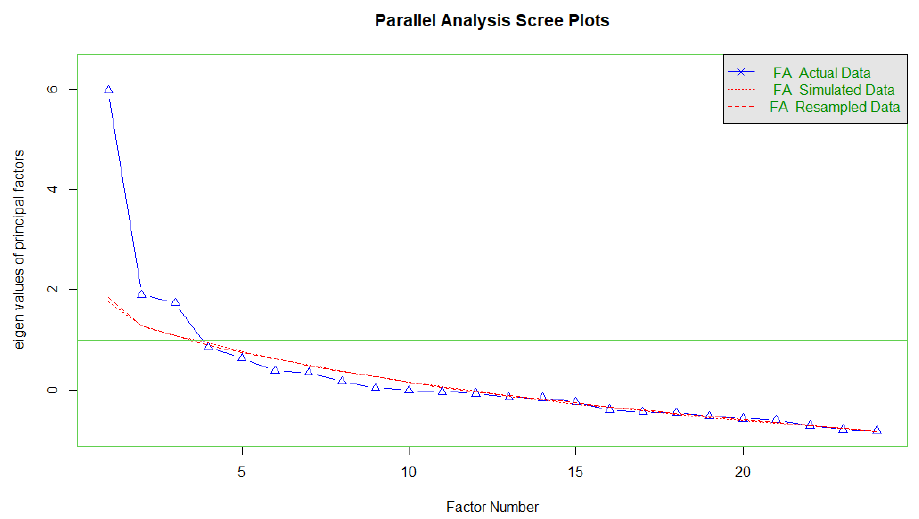
Figure 7. Scree test of eigenvalues.